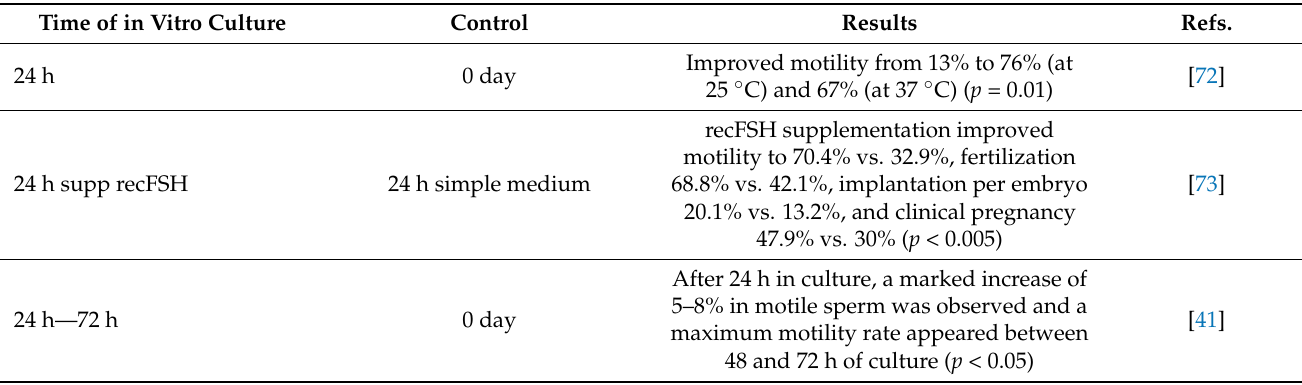
Table 3. Clinical results of short-term testicular tissue